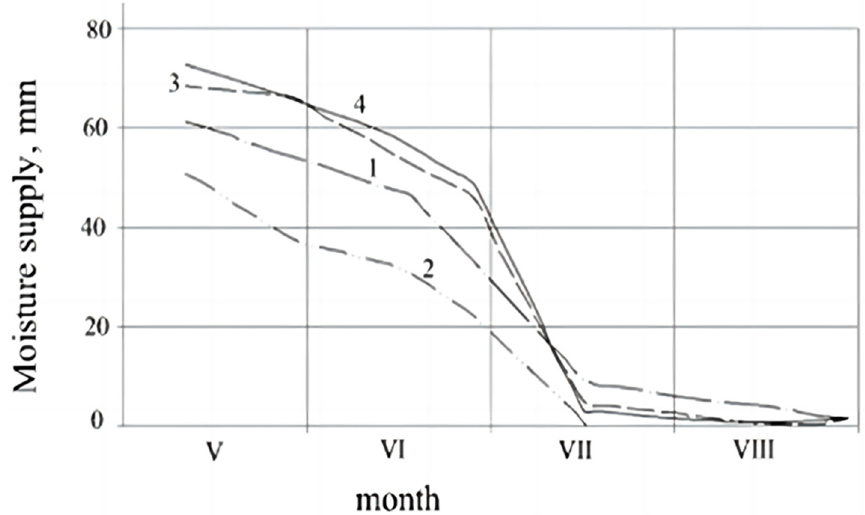
Figure 6. Dynamics of moisture available to plants (W) in dark-brown carbonate soil, depending on the treatment: 1—when disking (5 months-61 mm, 6 months-47 mm, 7 months-10 mm, 8 months-4 mm); 2—when loosening deep (5 months-52 mm, 6 months-31 mm, 7 months-0 mm); 3—when plowing normal (5 months-68 mm, 6 months-54 mm, 7 months-4 mm, 8 months-0 mm); 4—when plowing deep (5 months-74 mm, 6 months-58 mm, 7 months-3 mm, 8 months-0